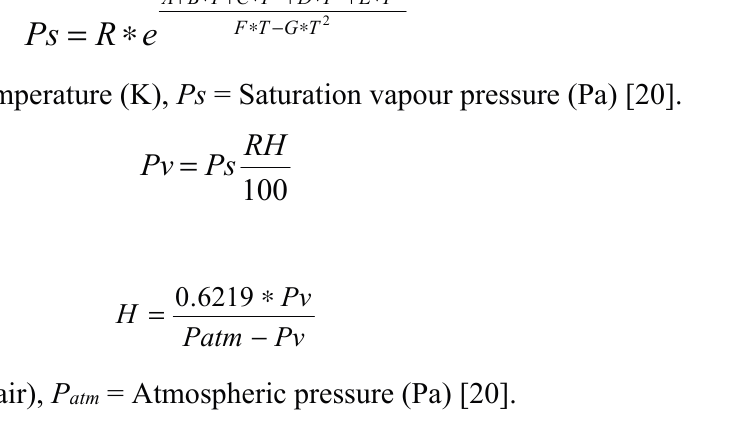
Table 2. Coefficients used to compute the psychrometric data, according to Equation (7) [20]. R =